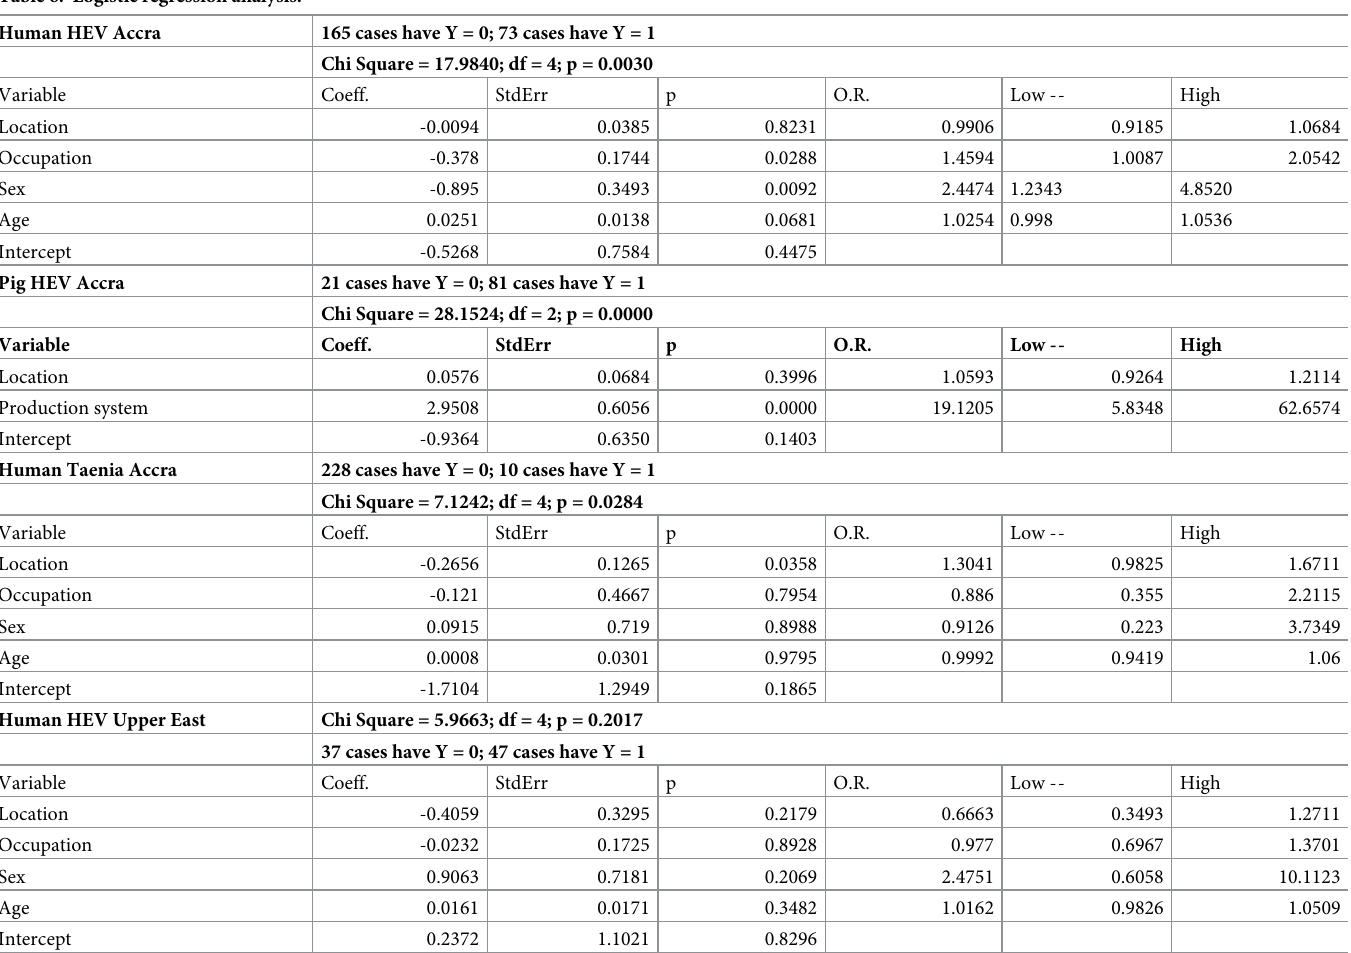
Table 6. Logistic regression